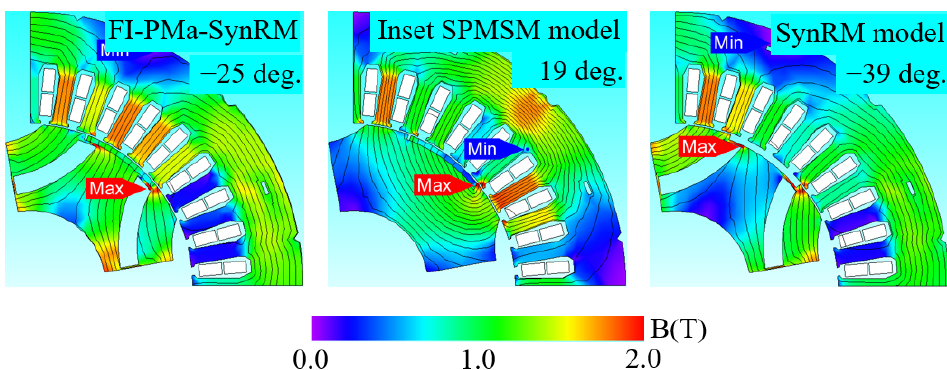
Figure 5. Motor flux densities at MTPA operation of motors. Left part: FI-PMa-SynRM; central part: Inset SPMSM; right part: SynRM.